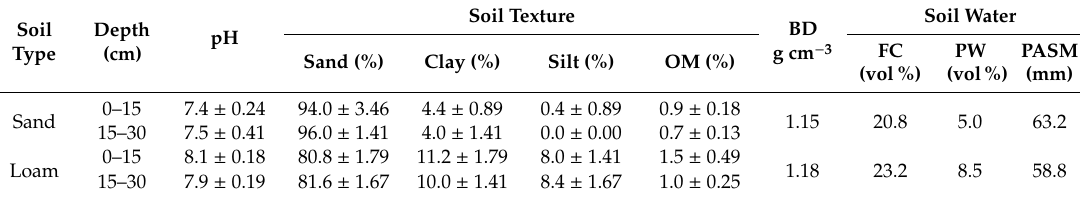
Table 2. Soil analyses and water relations for the two experimental fields. Sand: Sandy soil; Loam: Loamy sand; OM: Organic matter; BD: Bulk density; FC: Field capacity (pF 1.8); PW: Permanent wilting point (pF 4.2); PASM: Plant available soil